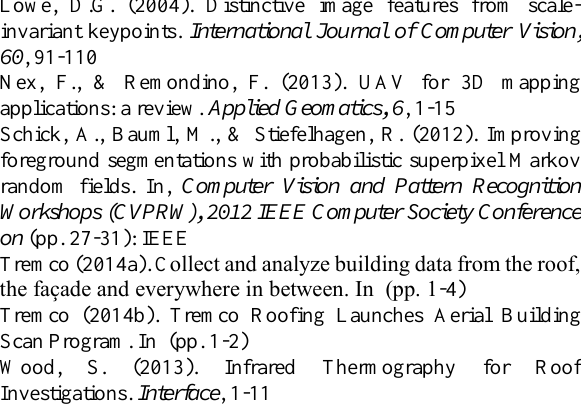
Figure 9: Original thermal images (left column) and thermal anomaly detection results based on SMRF (right